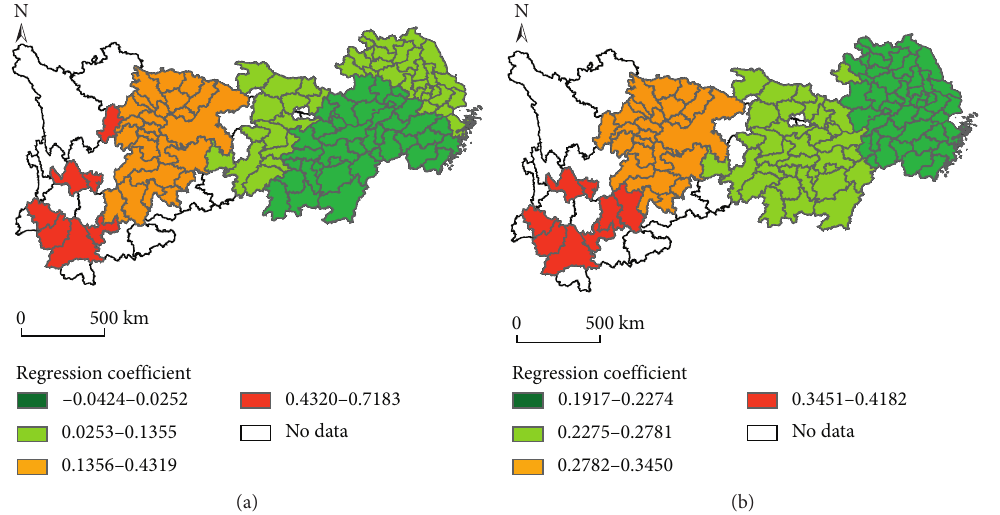
Figure 5: Spatial distribution of regression coefficients between innovation resources and innovation output. (a) Human resources. (b) Financial resources.